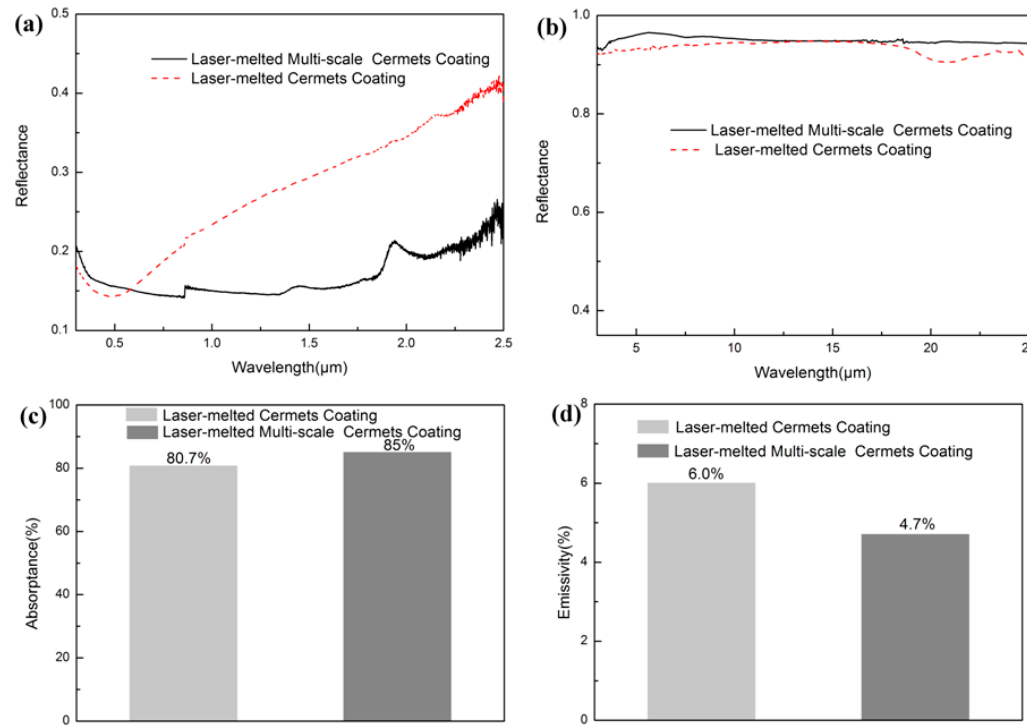
Figure 8. Reflectance spectra and absorption performance of the laser clad cermet coatings after heat treatment at 650 °C for 200 h: ( a ) reflectance spectra in the UV to near-IR regime, ( b ) reflectance spectra in the IR region, ( c ) absorptance of the coatings, and ( d ) emittance of the coatings.